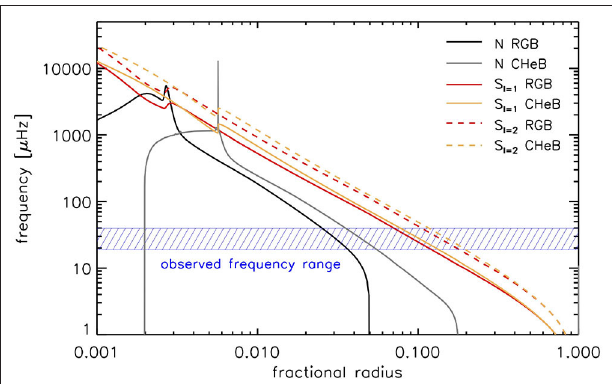
FIGURE 3 | Propagation diagram of a 1 M model of an ascending the ⊙ red-giant branch (RGB) star and a core helium burning (CHeB) star on the same evolutionary track. For the RGB model, the Brunt-Väisälä frequency N is shown in black and the Lamb frequency S for dipole ( l 1) and quadrupole = ( l 2) modes are shown with the red solid and dashed line, respectively. The = Brunt-Väisälä frequency and Lamb frequencies for the core helium burning (CHeB) model are indicated in gray and orange. The region around the ν max value of both models is indicated by the horizontal blue